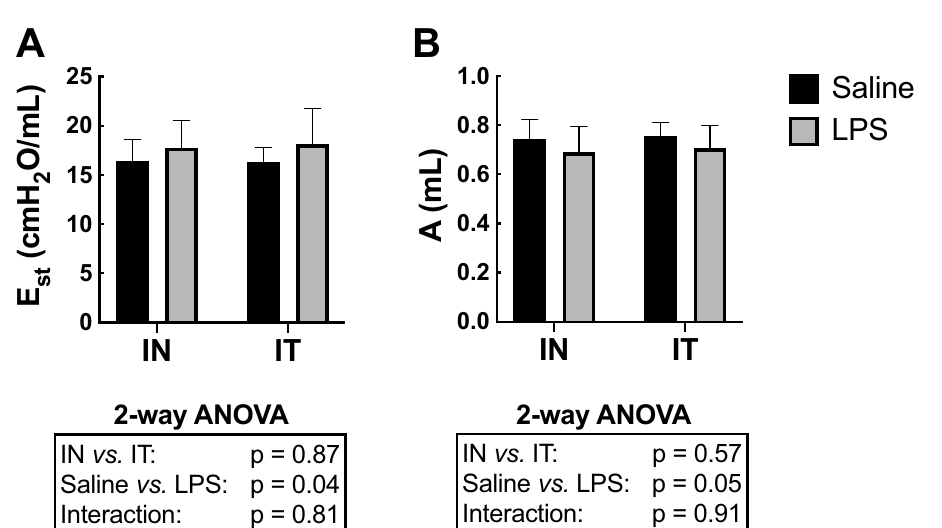
Figure 6. Respiratory mechanics. ( A ) The quasi-static elastance of the respiratory system (E st ) and ( B ) A (a proxy for the inspiratory capacity) are depicted for mice treated with either saline (black) or LPS (grey) through either the intranasal (IN) or the intratracheal (IT) route. The results of the two-way ANOVA are shown at the bottom of each graph. n = 12 per group and the data shown are means ±